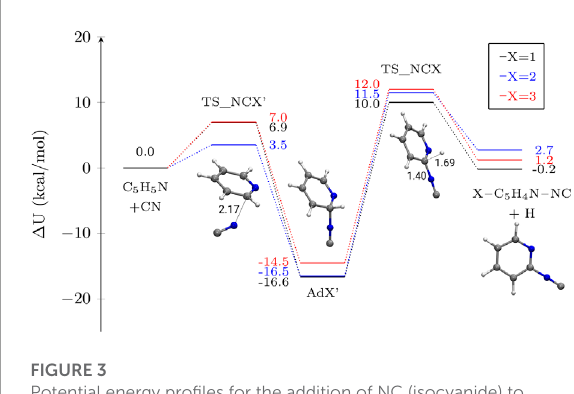
FIGURE 3 Potential energy profiles for the addition of NC (isocyanide) to pyridine in different atomic positions. The depicted magnitude is Δ U (electronic energy + ZPVE) in kcal mol −1 . Molecular structures of the stationary points on the different PES other than pyridine are shown for X = 1 as an example. Distances are given in